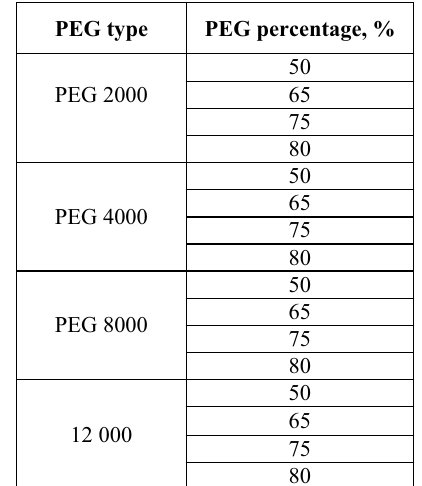
Table 1. PEG type and percentage used for the